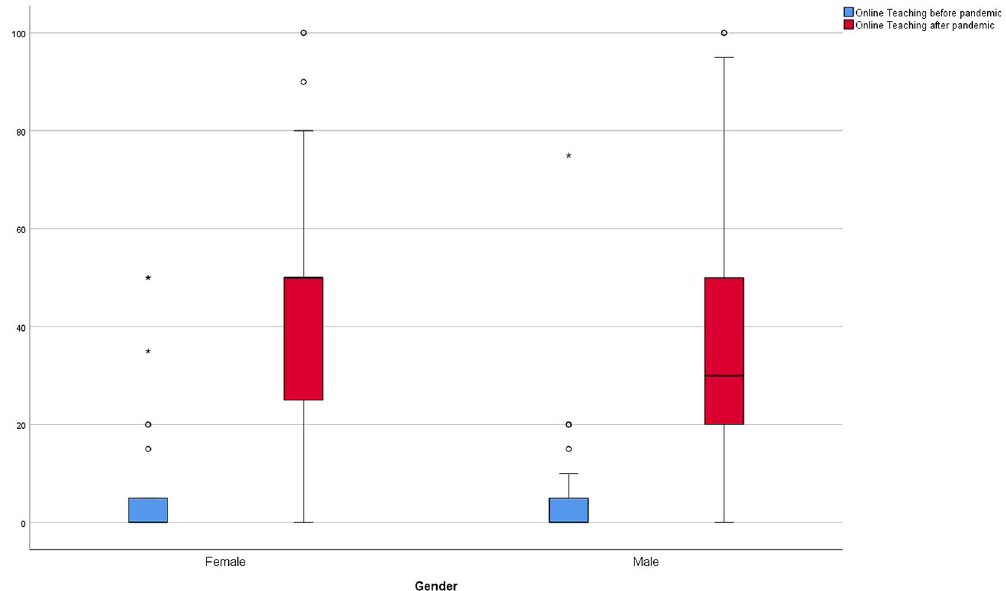
Figure 6. Results of online teaching before and after Covid pandemic of participants in % divided by